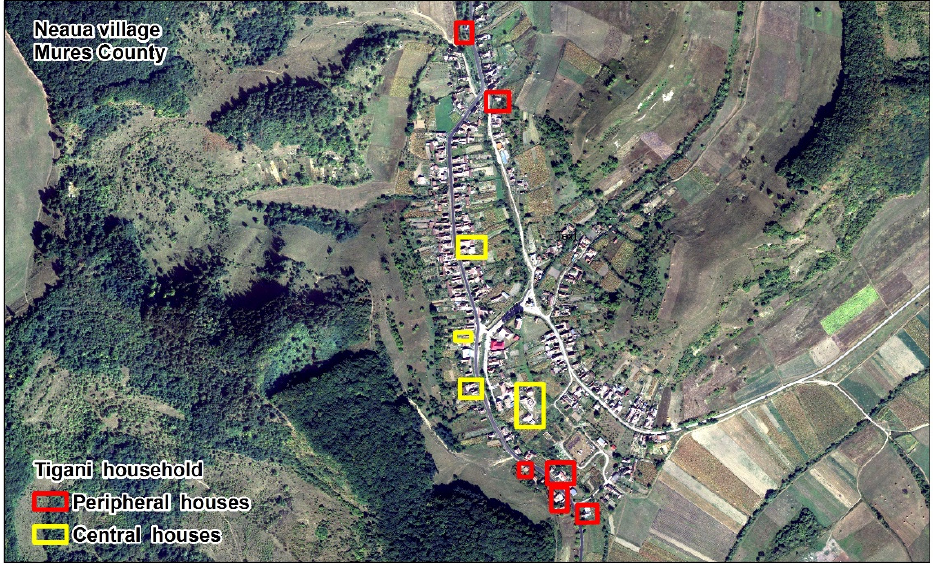
Figure 2. Neaua village peripheral and central Ț igani households [26].